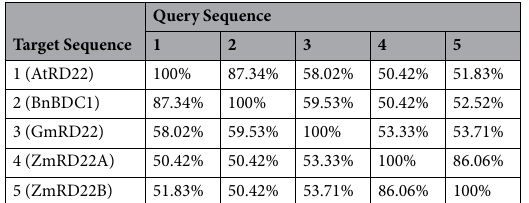
Table 1. Percentage identity matrix for the alignment of five BURP-domain containing protein sequences.